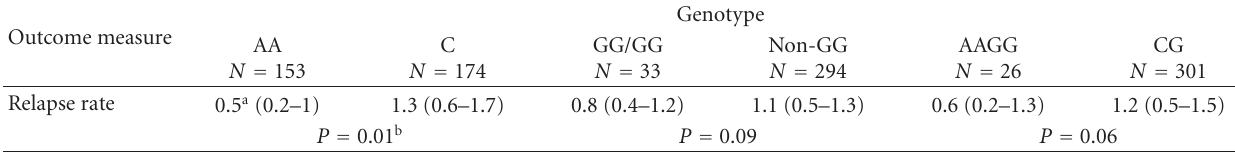
Table 4: Relapse rate in patients with bout onset displaying di ff erent OPN genotypes. Outcome